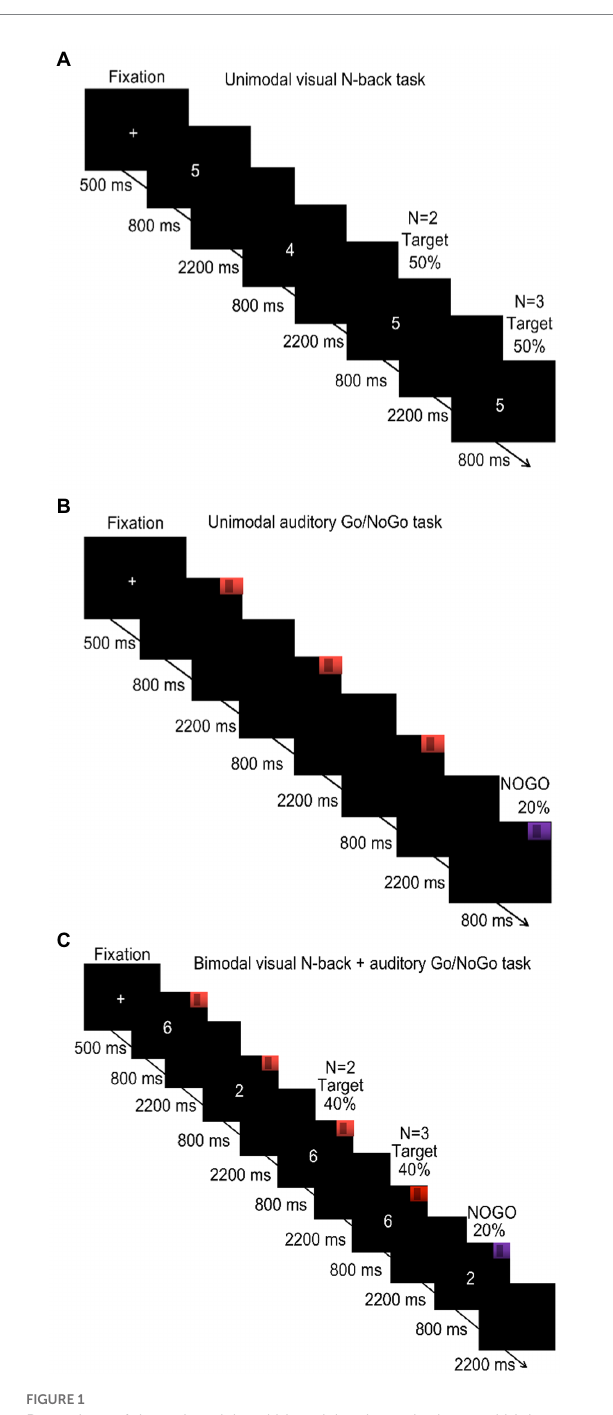
FIGURE 1 Procedure of the unimodal and bimodal tasks under low and high cognitive loads (N of 2 and 3, respectively). (A) Unimodal visual N-back task under low ( N = 2) and high cognitive load ( N = 3); (B) unimodal auditory Go/NoGo task; (C) bimodal visual N-back + auditory Go/NoGo task under low ( N = 2) and high cognitive load ( N =